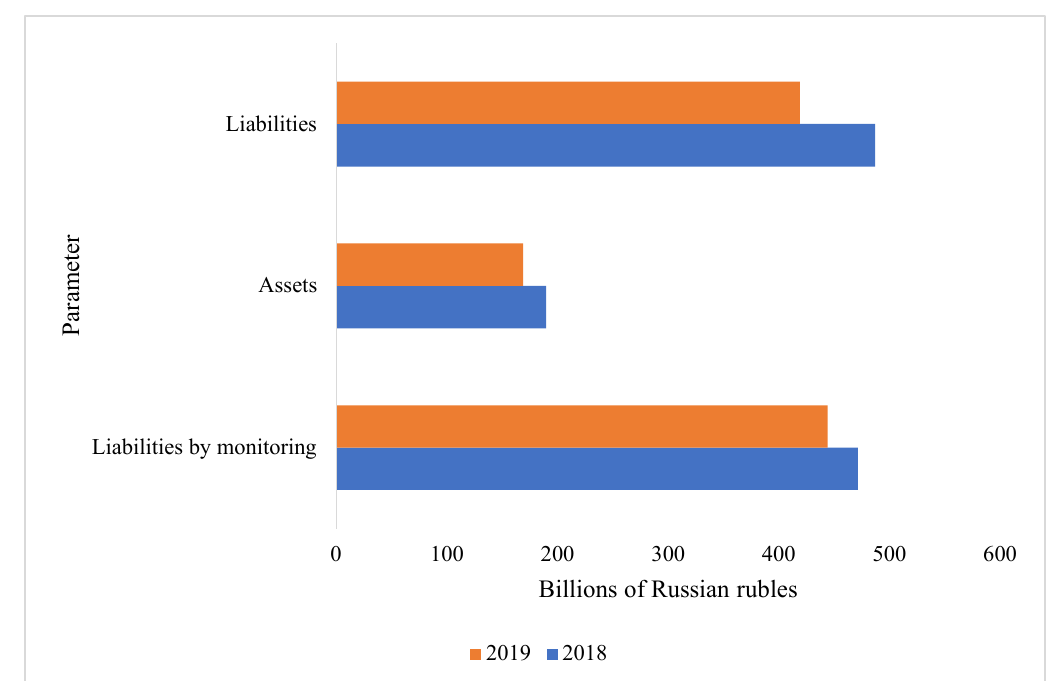
Figure A1. Structure of banks under bankruptcy procedure in 2011–2019.